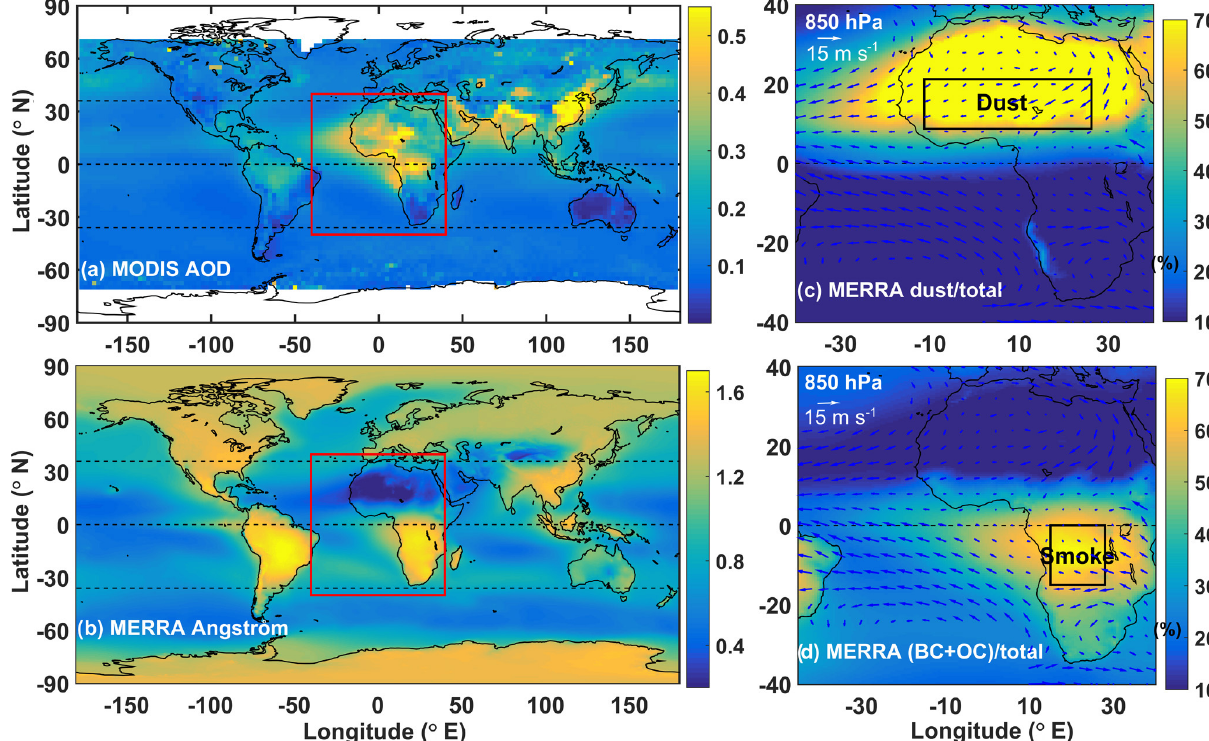
Figure 1. Spatial distributions of (a) aerosol optical depth (AOD) at 550nm derived from the MODIS at a spatial resolution of 1 ◦ × 1 ◦ and (b) the total aerosol Ångström parameter (470–870nm) from the MERRA dataset on a 0.625 ◦ × 0.5 ◦ grid for the period 2003–2013 including all seasons. The red rectangle outlines the region of interest. (c) The ratio of dust AOD to total AOD over the region of interest and (d) the ratio of carbonaceous aerosol (black carbon and organic carbon: BC + OC) AOD to total AOD over the region of interest derived from the MERRAero dataset (da Silva et al., 2015). Also shown is the 850hPa mean wind field from the ERA-Interim reanalysis with a spatial resolution of 1 ◦ × 1 ◦ in panels (c) and (d)